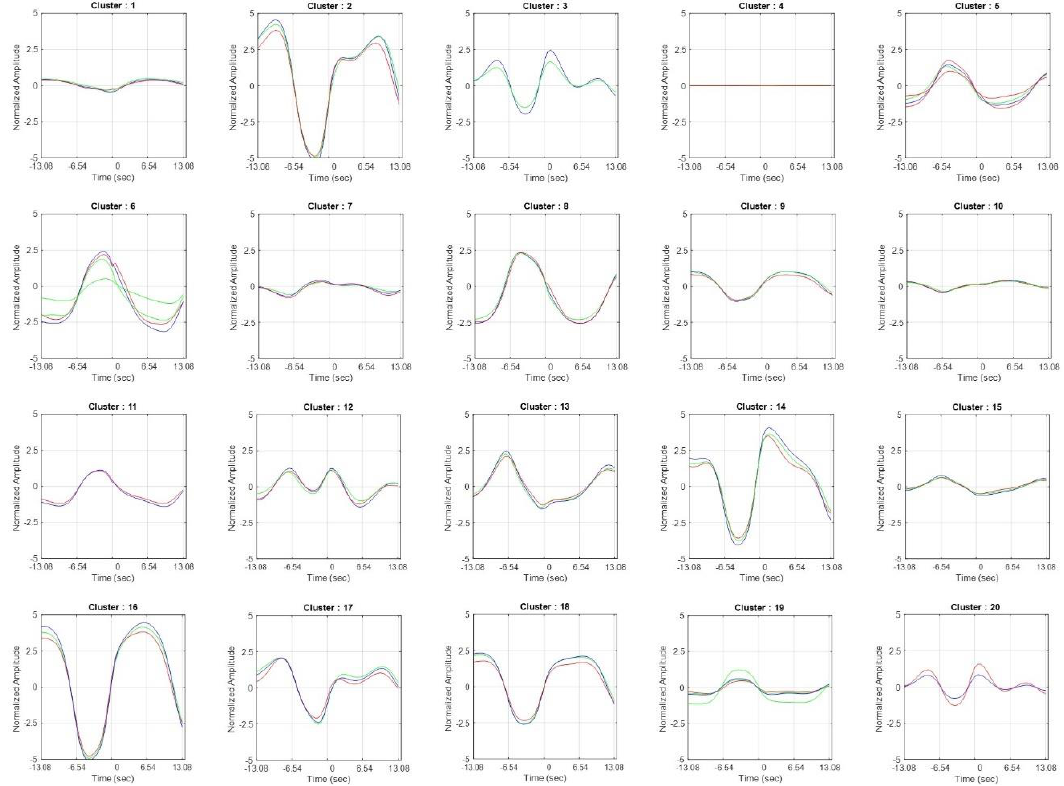
Figure A5. Temporal for each of the 20 spatial cluster shown in Figure A4. The response for ‘yes’ apps is shown in green; ‘no’ apps is shown in red and the case for all user decision (both yes and no) is shown in blue. The x-axis represents normalized time that is centered at the beginning of new app (new stimulus), while the y-axis represents the averaged normalized amplitude.